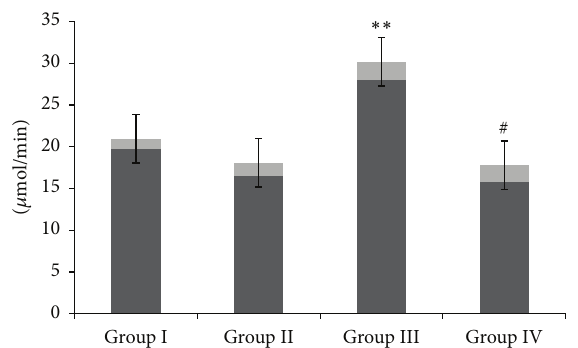
Figure 4: Effect of camel milk and gentamicin on myeloperoxidase activity. Effect of CM administration on GM induced renal MPO activity. Values are expressed as mean ± SEM ( 𝑛 = 6 ). ∗∗ 𝑃 < 0.01 shows significant difference in group III when compared with group I. # 𝑃 < 0.05 showssignificantdifferenceingroupIVwhencompared with group